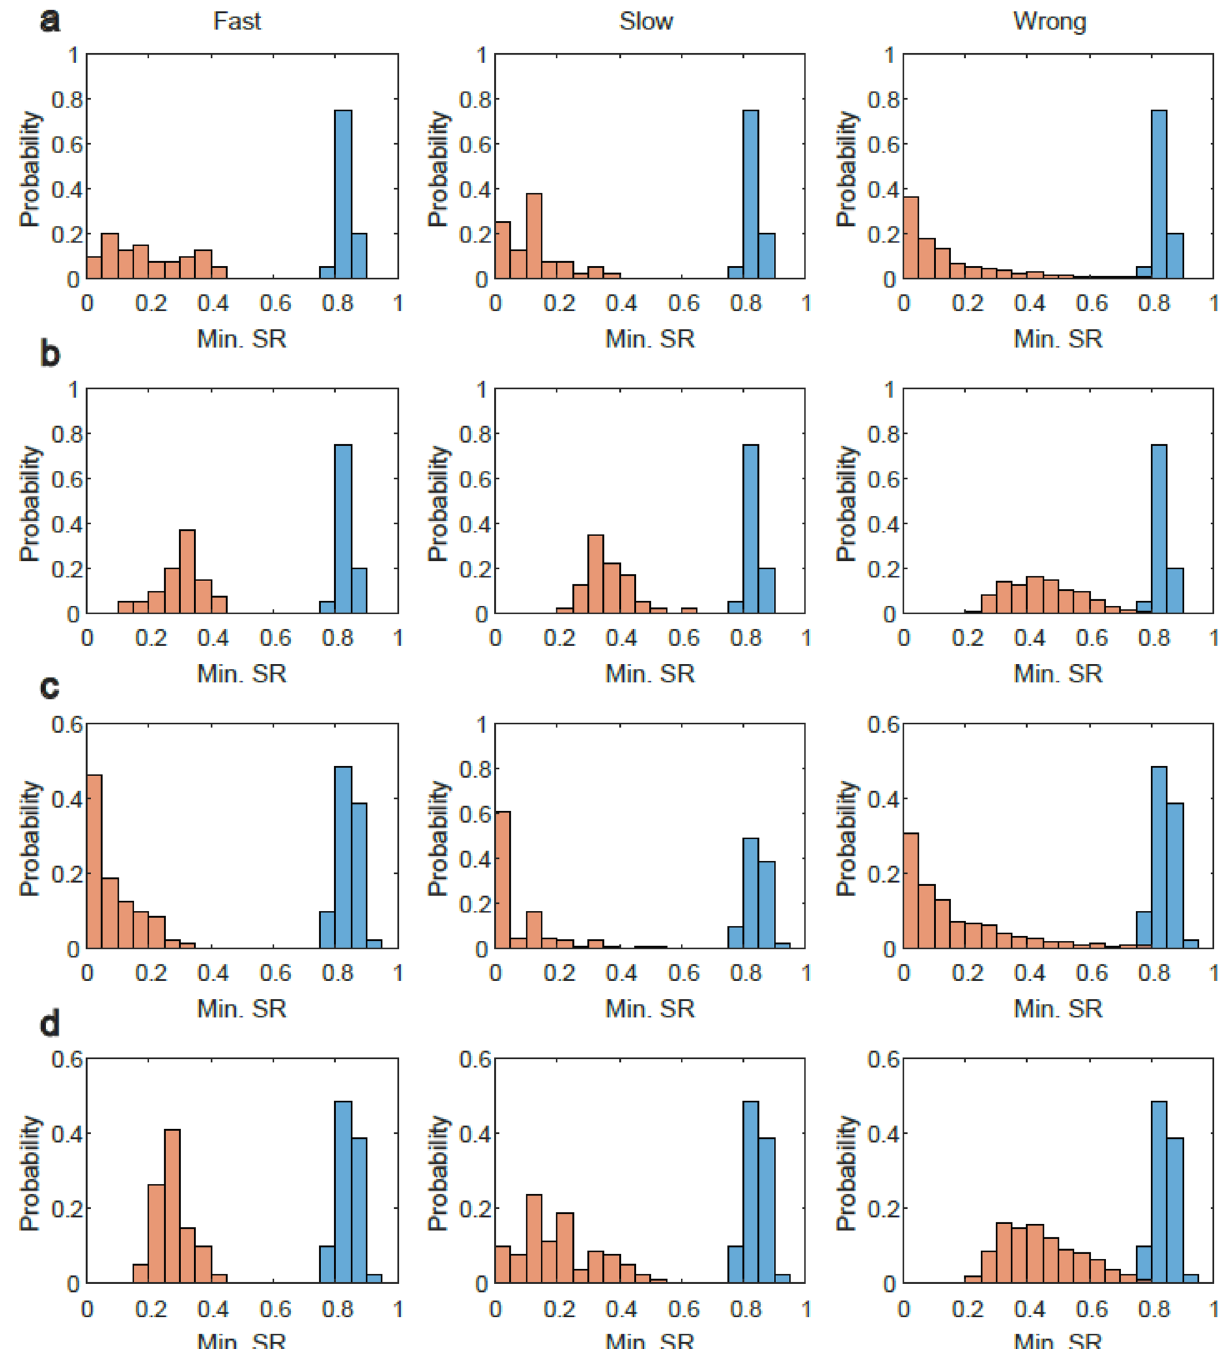
Figure 2. Robustness of the ID-net to three types of imperfect sequences. ID-net (Fig. 1b) is trained using 1000 training sequences that each comprises 10 MNIST digits with d = 30 and d 1 = 20 frames (Fig. 1c), separated by 10 ms with consecutive digits separated by (cid:31) t = 200 ms (“Methods”). ( a ) Blue histograms are constructed from the minimal SR for the individual digits in each trained sequence. Similarly, the orange histograms are constructed from the minimal digit SR for the three types of imperfect test sequences: fast/slow/wrong. (The ID-net knows the order of the trained sequence (“Methods”). ( b ) Similar to ( a ), except that the ID-net does not know the order of the trained sequence. ( c ) Similar to ( a ), except that two sequences are embedded in the ID-net . The order of two sequences is identical, except for the swapping of one pair of digits. ( d) Similar to ( b ), except with two embedded sequences. Each histogram in ( a – d ) comprising 40 samples